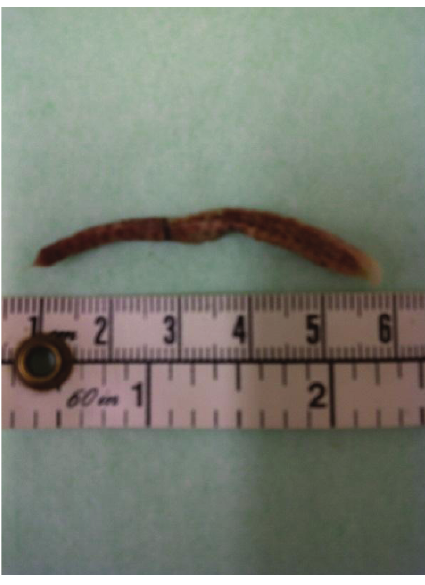
Figure 1: The spontaneously extruded transobturator tape